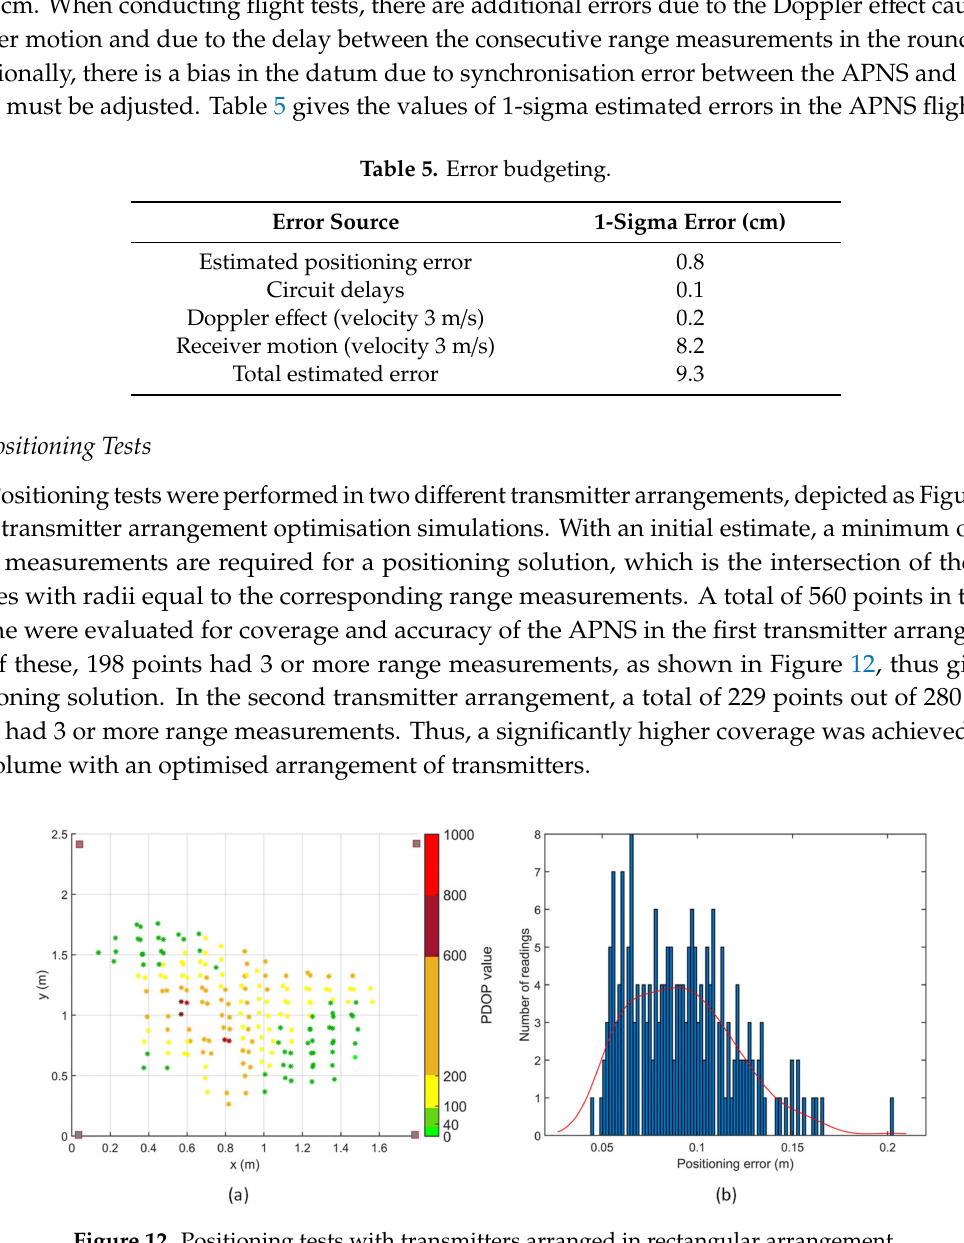
Figure 12. Positioning tests with transmitters arranged in rectangular